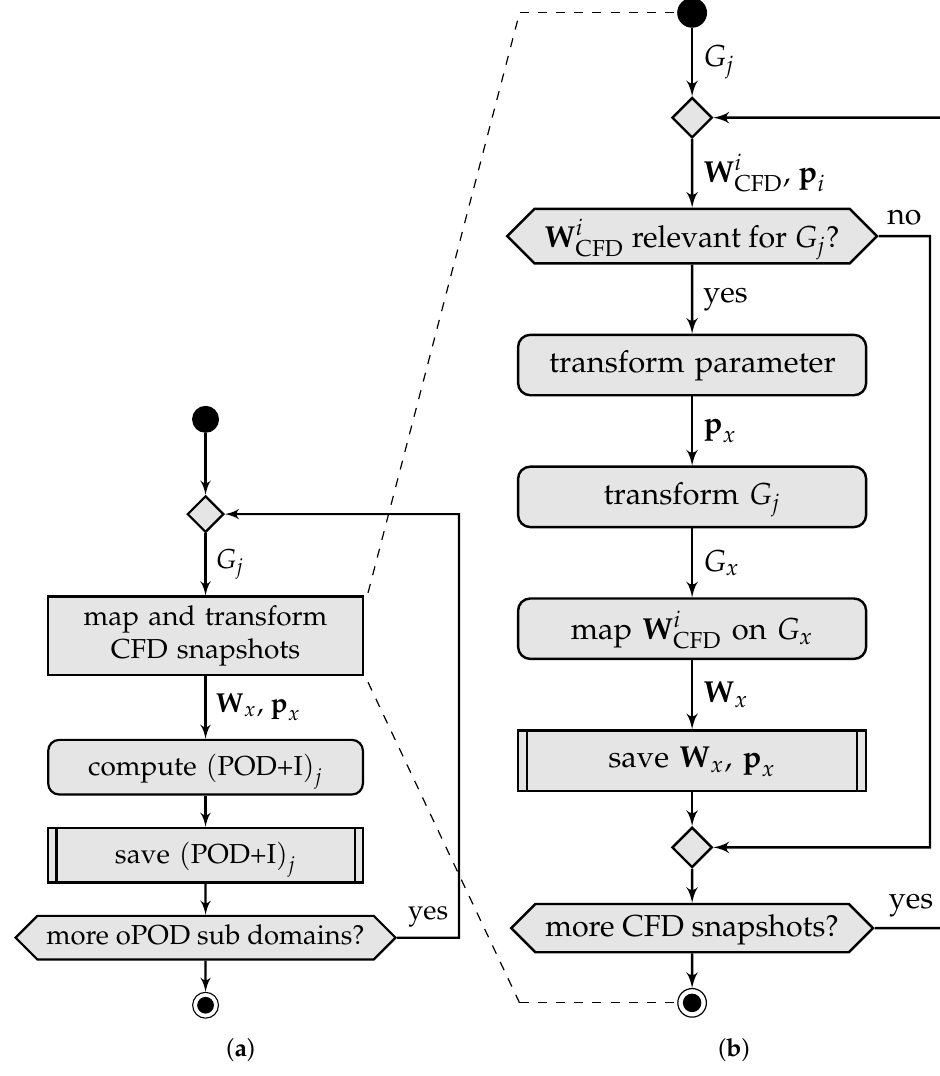
Figure 4. Flowchart for the computation of the oPOD subdomain POD+I models. ( a ) Computation of the oPOD subdomain POD+I model. ( b ) Transformation and mapping of oPOD subdomain reference grid to a specific CFD